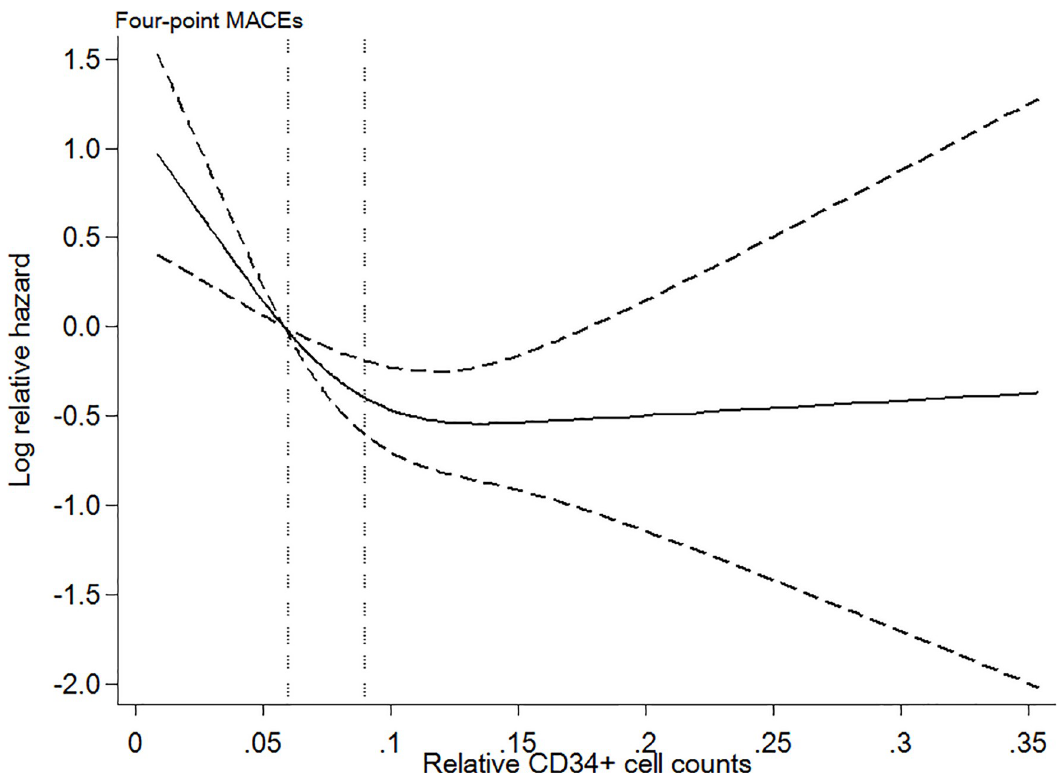
Fig 3. Log relative hazard of 4-point MACEs for relative CD34 + cell counts in the restricted cubic spline curve. The reference is the cut-off point between the lowest and medium tertiles; the two vertical dotted lines indicate the cut-off for these tertiles (0.06 and 0.09, respectively). The graph has three knots that are truncated at the 1 st and 99 th percentiles.